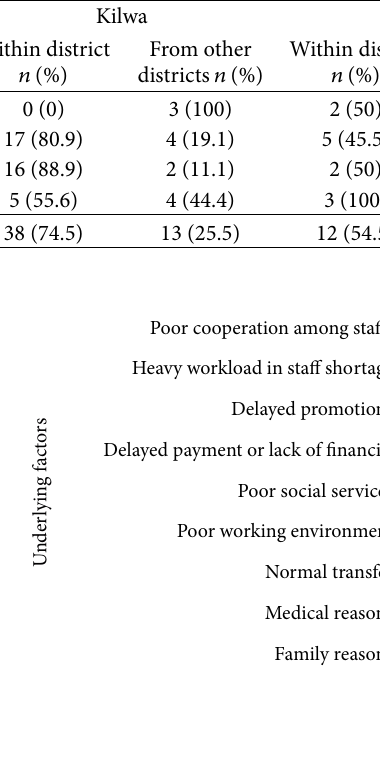
Table 4: Migration of health workers between 2011 and 2015 in Kilwa and Rombo districts.